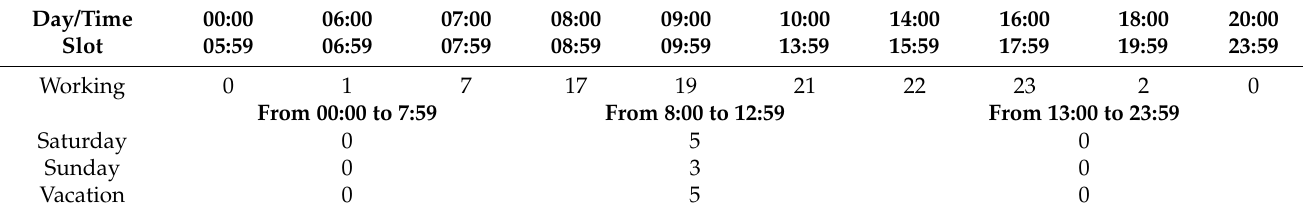
Figure 8. HVAC consumption per days of the week .